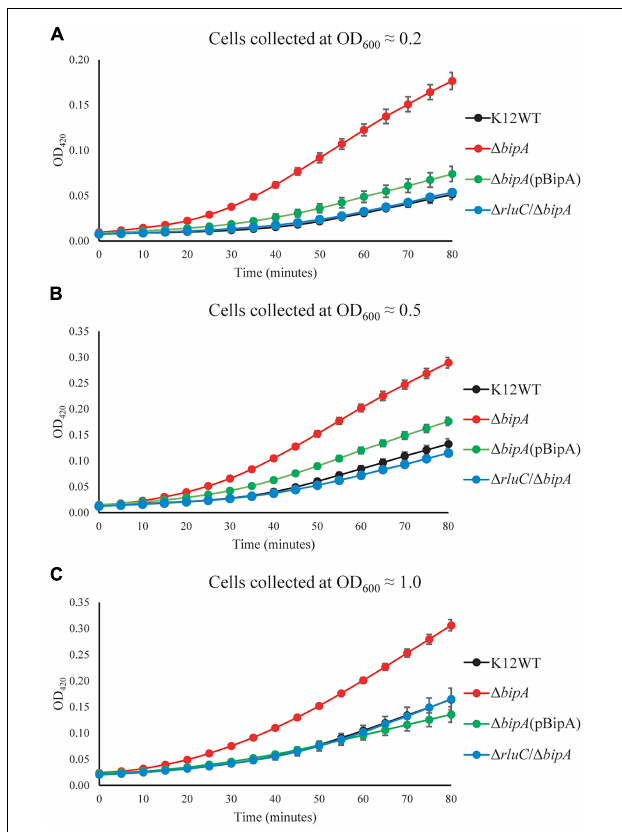
FIGURE 5 | β -galactosidase activity assays demonstrated the upregulation of DeaD in the strain (cid:49) bipA . The cells were harvested at OD 600 ≈ 0.2 (A) , 0.5 (B) , and 1.0 (C) , respectively, and the activity was assessed by measuring the breakdown of ONPG through recording OD 420 . (cid:49) bipA cells (red) harvested at all three OD 600 presented the highest β -galactosidase activity, indicated by the significantly stronger OD 420 absorbance over time as compared to K12WT (black), (cid:49) bipA (pCA24N-BipA) (green), and (cid:49) rluC / (cid:49) bipA (blue). The pBipA refers to